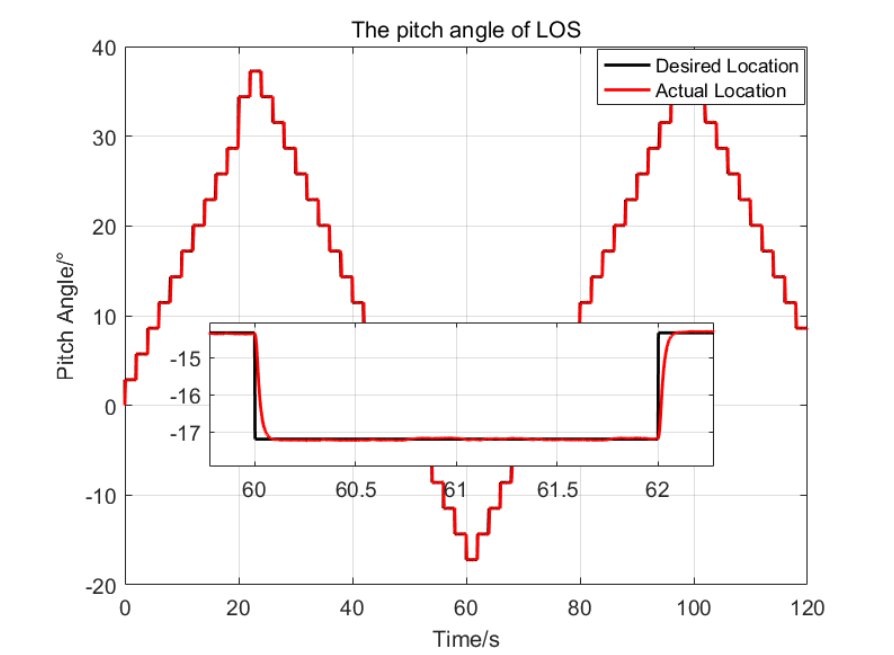
Figure 12. The tracking trajectory of the pitch with the proposed method.